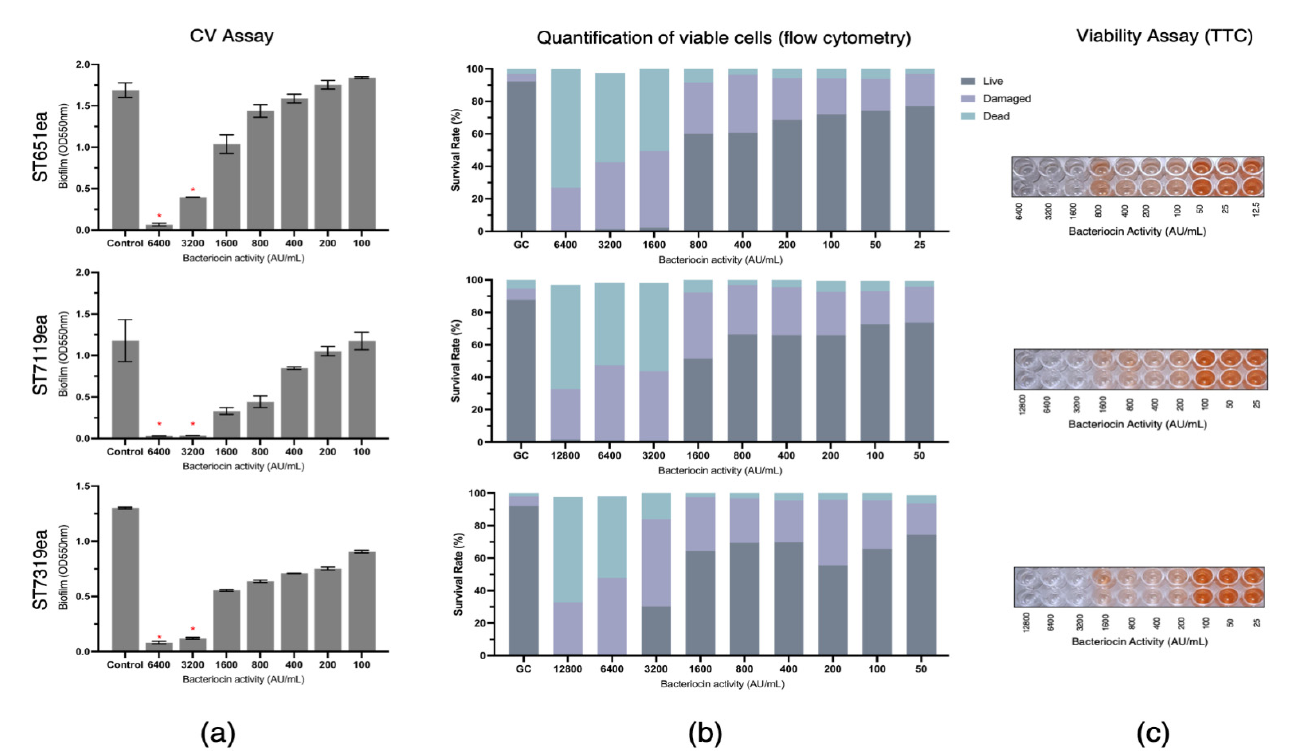
Figure 1. Eradication of Listeria monocytogenes ATCC14313 biofilm by semi-purified bacteriocins ST651ea, ST7119ea, and ST7319ea after 1 h challenge. Biofilms were quantified by ( a ) crystal violet assay (significant changes in biofilms after challenge were indicated by * at p ≤ 0.05 ); ( b ) quantification of live, dead, and damaged cells through flow cytometry; and confirmation of ( c ) cell viability using TTC.